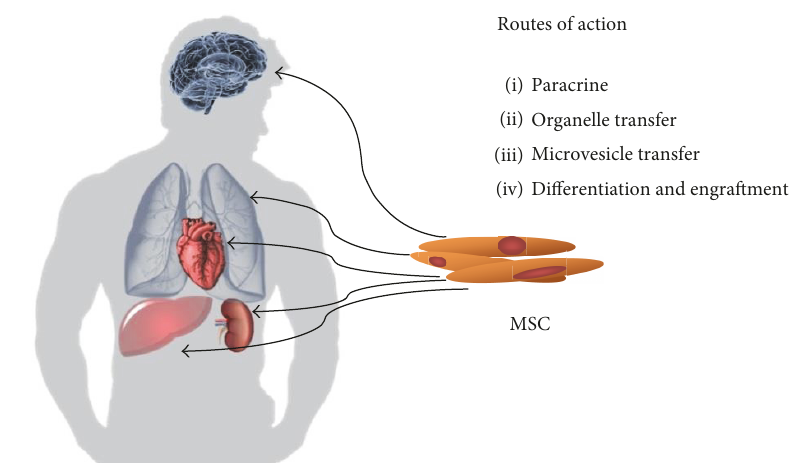
Figure 1: Mechanisms and means of MSC